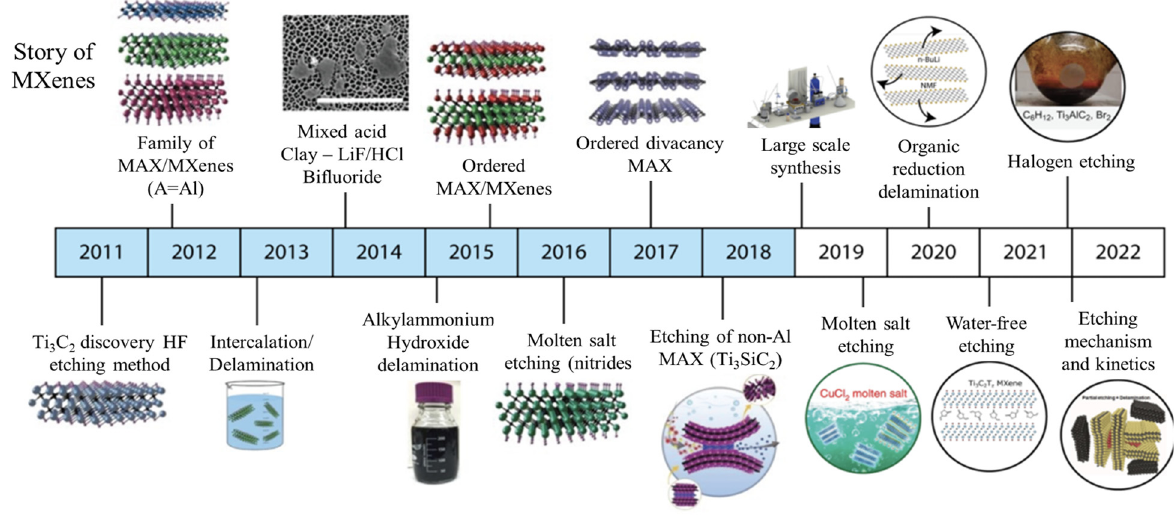
Figure 3. Synthesis methods of MXene from 2011–2022 [35–43].